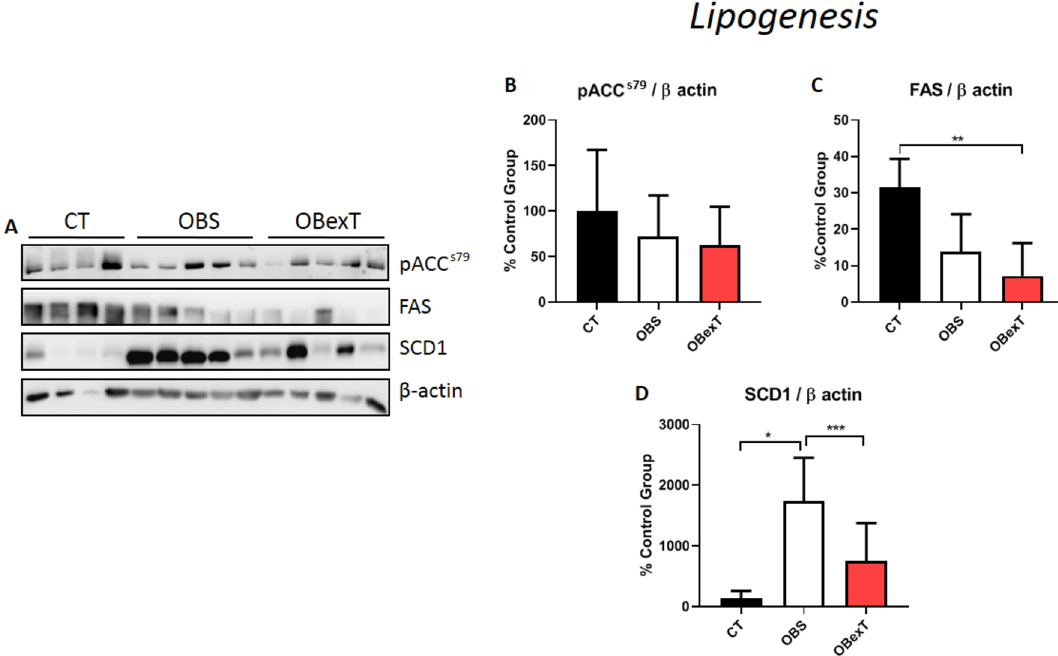
Figure 5. Total protein extract obtained from the sWAT was used for Western Blotting experiments. Uncut images can be viewed in the supplementary material. The membranes were cut at the specific height of the target protein. ( A ) The protein content of ( B ) pACC ser79 , ( C ) FAS, and ( D ) SCD1. The signal of statistical difference are represented as follows, * p < 0.05 CT versus OBS, ** p < 0.05 CT versus OBexT and *** p < 0.05 OBS versus OBexT (n = 4 CT group; n = 5 OBS group; n = 5 OBexT group). One-way Anova statistical analysis was used, followed by Tukey’s